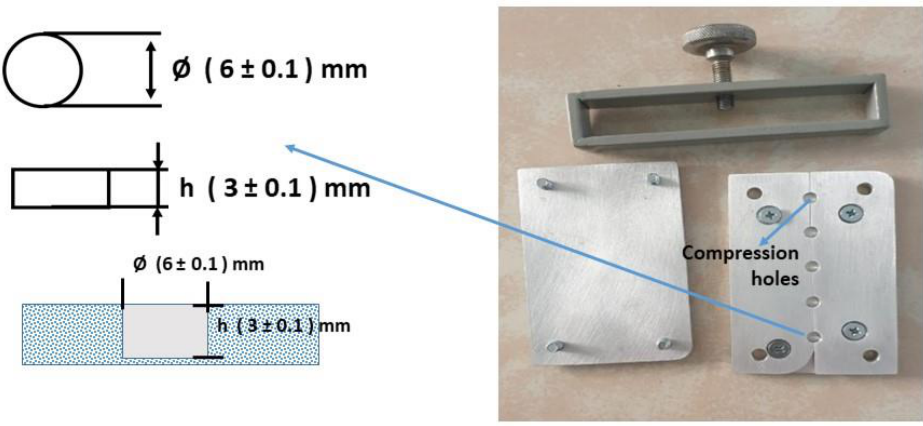
Figure 1. The compression molding of nanocomposite sample for DTS test.